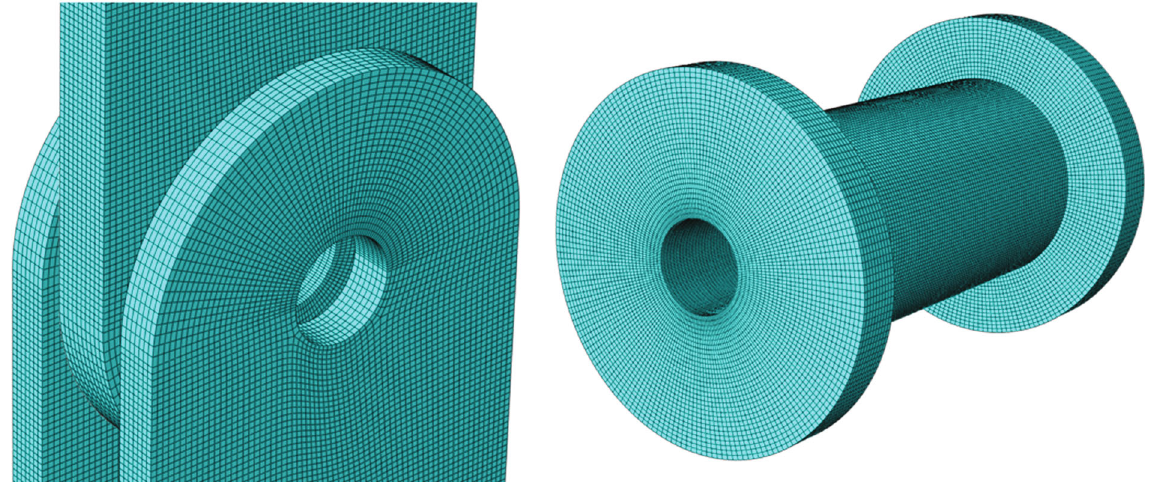
Figure 3: Mesh of the shear pin and its connecting